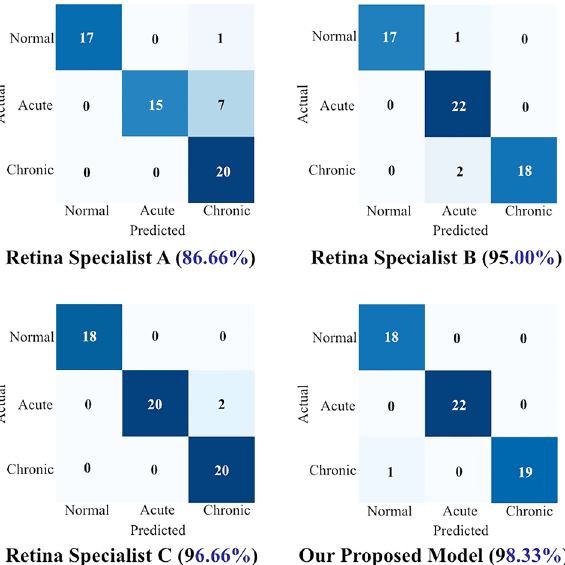
Figure 2. Confusion matrix comparison between our proposed model and the three retina specialists. The confusion matrix shows the confusion matrix of the 4th fold from the fivefold cross-validation. The x-axis denotes the predicted class and the y-axis denotes the actual class of a given patient. Our proposed model showed 98.3% accuracy and accurately classified all cases except for one normal case. All the retina experts had more than 10 years of clinical